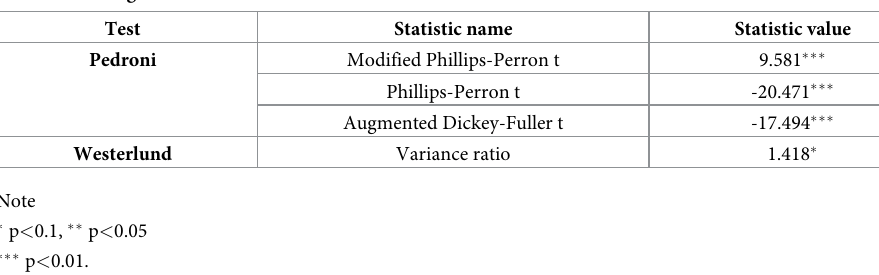
Table 7. Cointegration